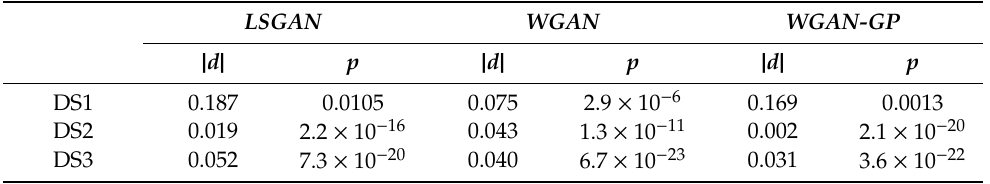
Table 3. Best obtained absolute di ff erence and p value calculations for robust equivalency testing of each of the synthesized distributions using di ff erent